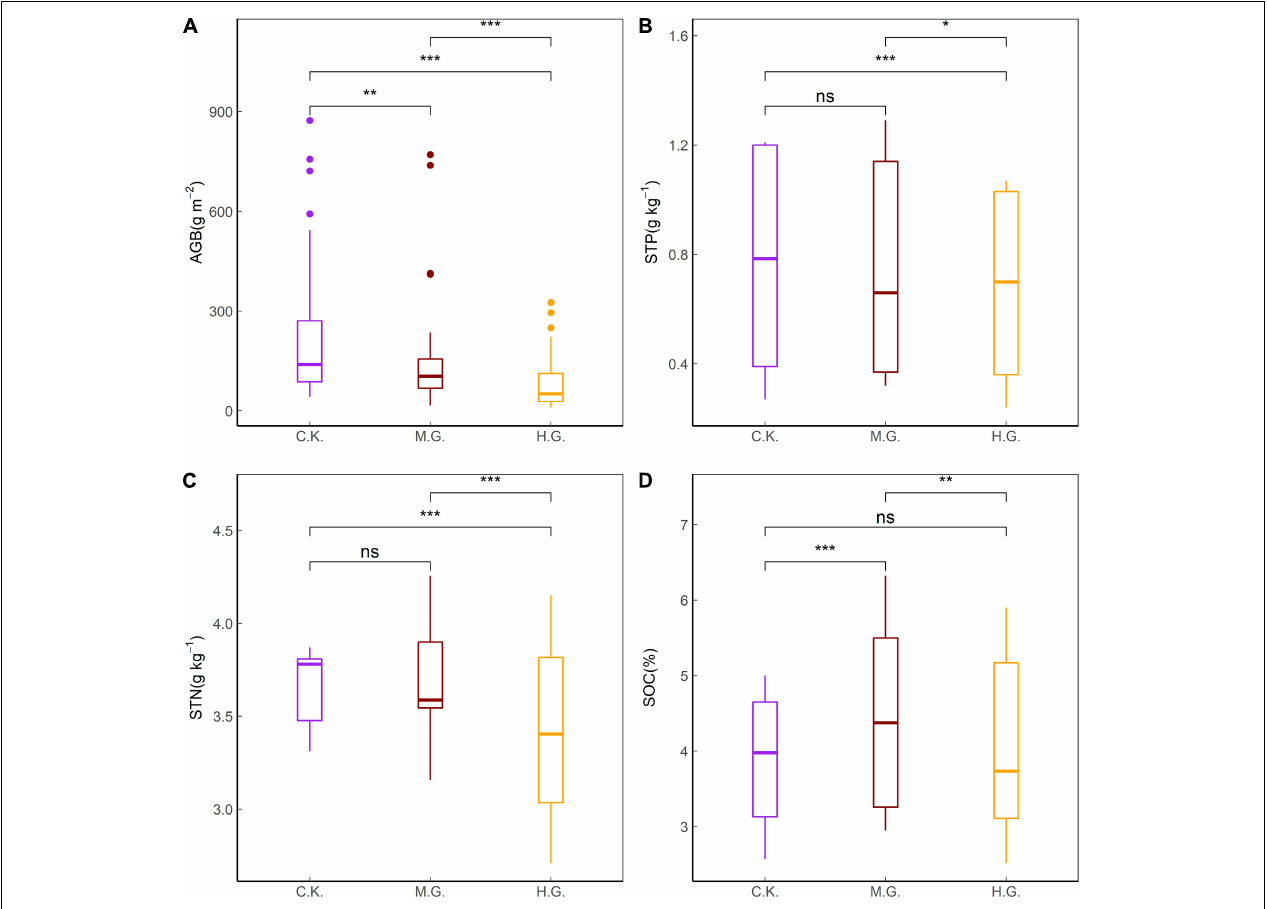
FIGURE 4 | Comparisons of AGB (A) , STP (B) , STN (C) , and SOC (D) between grazing treatments. The differences were at the ***0.001, **0.01, and *0.05 levels. The treatments include grazing exclusion (C.K.), moderate grazing (M.G.), and heavy grazing (H.G.).